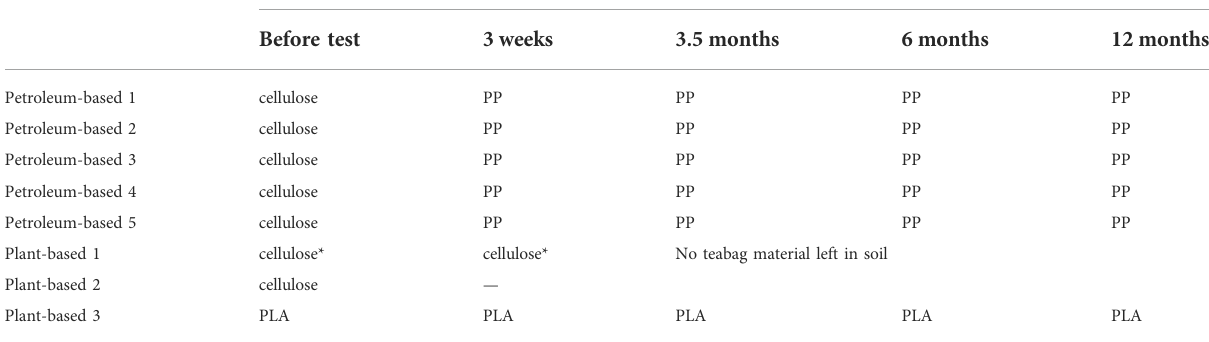
TABLE 2 Polymeric composition of teabag samples before and after soil burial, as demonstrated by FTIR-ATR. It should be noted that plant-based 1 also contains PLA in lower ratio than cellulose (as shared privately by the brand) but was not detected spectroscopically. Sample